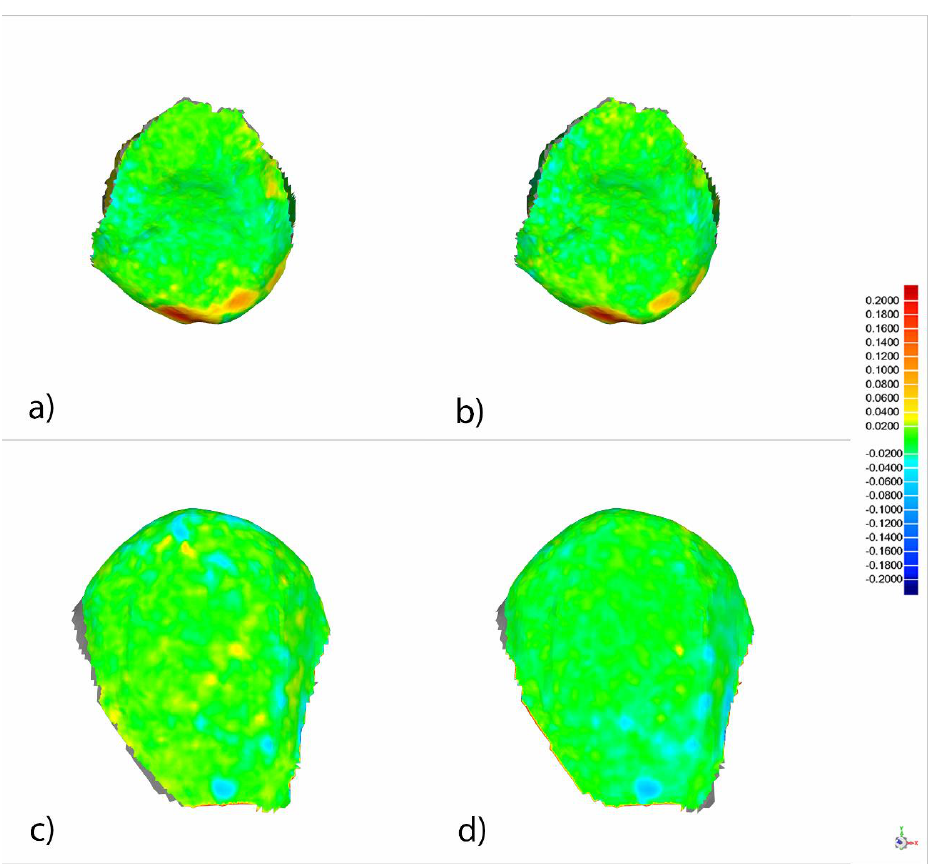
Figure 1. Palatal view of the alignment rate between the segmented and realigned the standard tessellation language 1 (STL1) and STL2 digital files ( a ) and between the segmented and realigned STL1 and STL3 digital files ( b ) of tooth 1.5 from the experimental model of the palatal multibracket appliance therapy. Buccal view of the alignment rate between the segmented and realigned STL1 and STL2 digital files ( c ) and between the segmented and realigned STL1 and STL3 digital files ( d ) of tooth 1.5 from the experimental model of the buccal multibracket appliance therapy. Warm colors represent a volume increase, cold colors represent a volume decrease, and green represents accurate alignment. Current values expressed in millimeters.